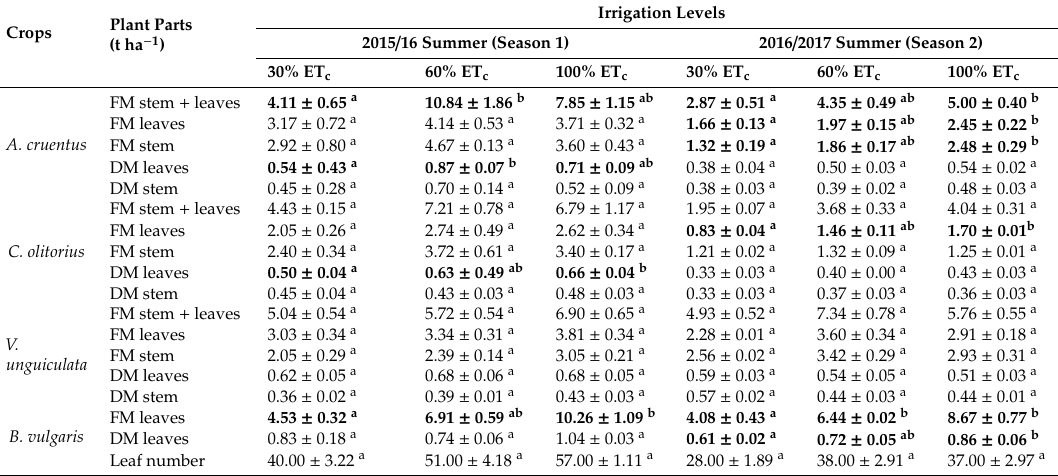
Table 4. E ff ect of irrigation on the yield of selected African leafy vegetables obtained from two growing